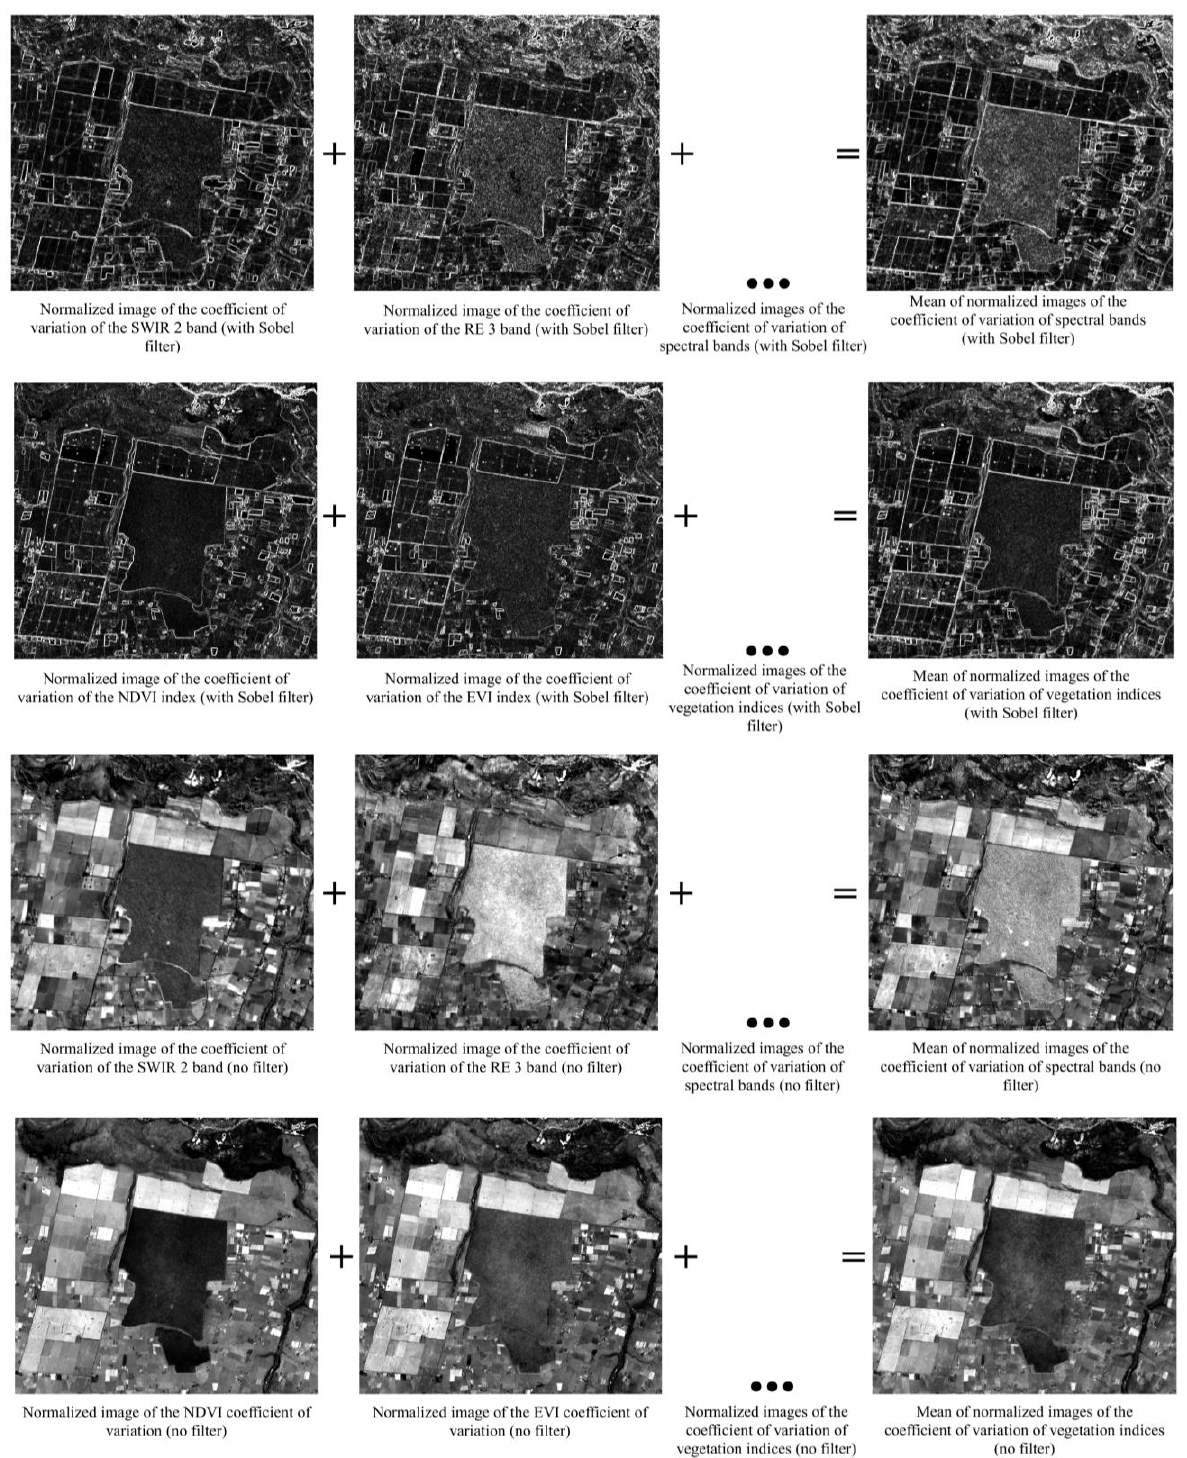
Figure 3 . Illustration of the images used as input in the multitemporal segmentation, based on the method proposed by Watkins & Van Niekerk